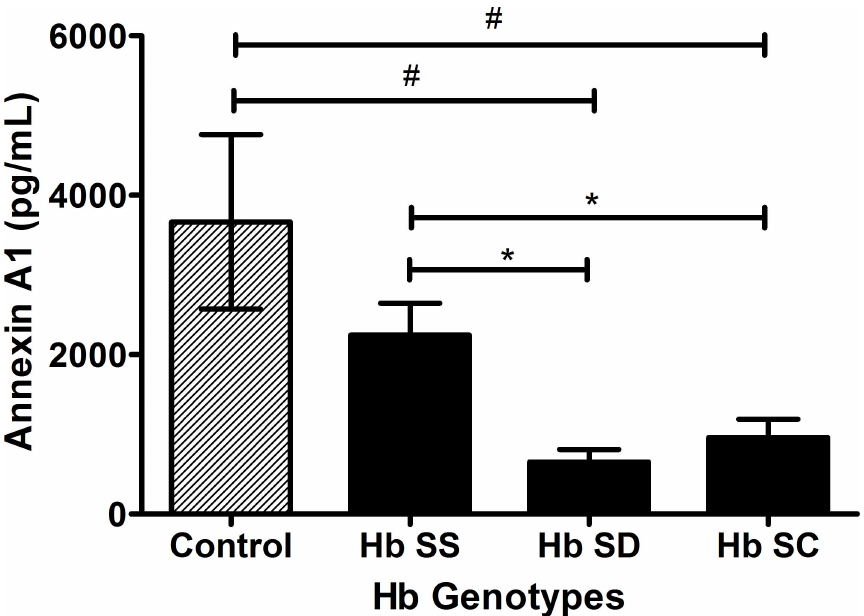
Fig 3. Plasma levels of ANXA1 in control group and SCD genotypes. Data expressed in mean ± standard error of the mean. Statistical analysis: one-way ANOVA . * p < 0.05 for Tukey-Krumer post hoc . # p < 0.05 for Dunnett’s post hoc .